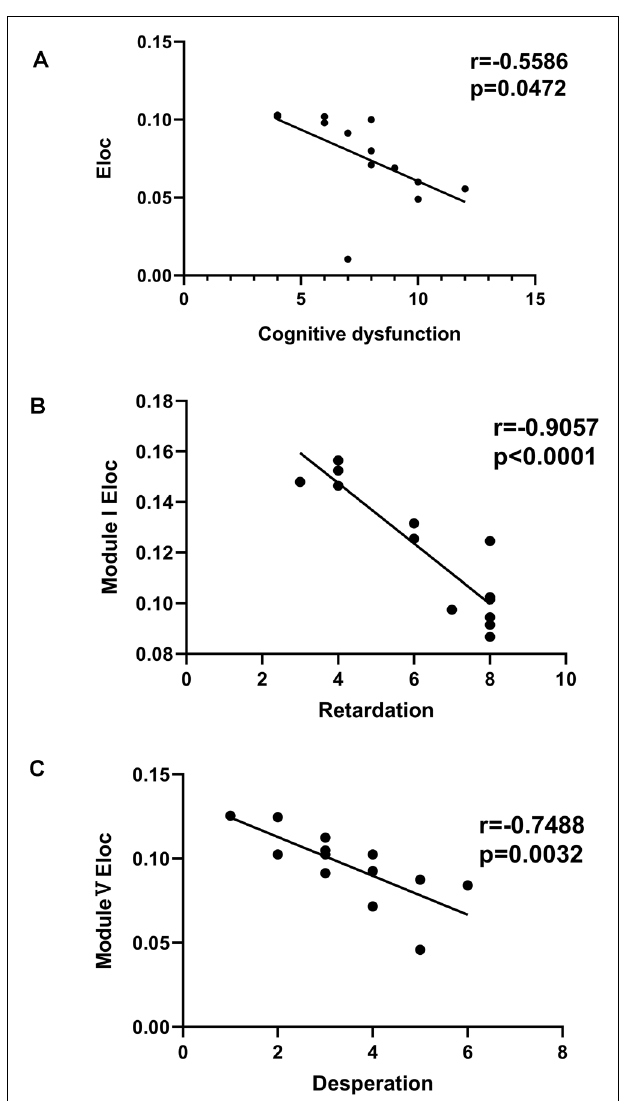
FIGURE 6 | Correlation analysis between clinical variables and global efficiency in the PSD group. (A) There was a negative correlation between the nodal global efficiency and the cognitive dysfunction score. (B) In Module I, there was a negative correlation between the nodal global efficiency and the retardation score. (C) The nodal global efficiency in Modules V showed a negative correlation with the desperation